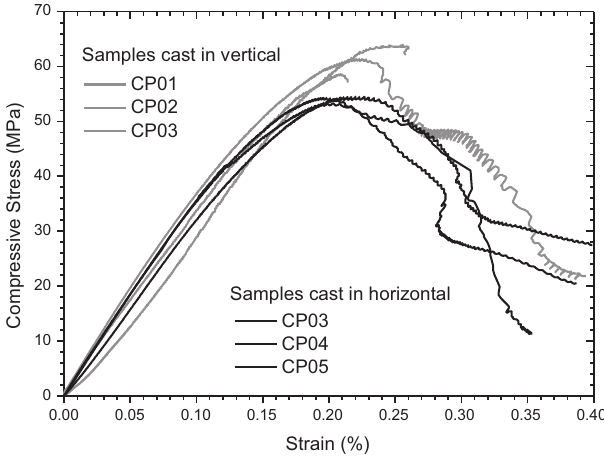
Stress vs. strain plots for additional samples cast in vertical (grey) and horizontal (black) PVC